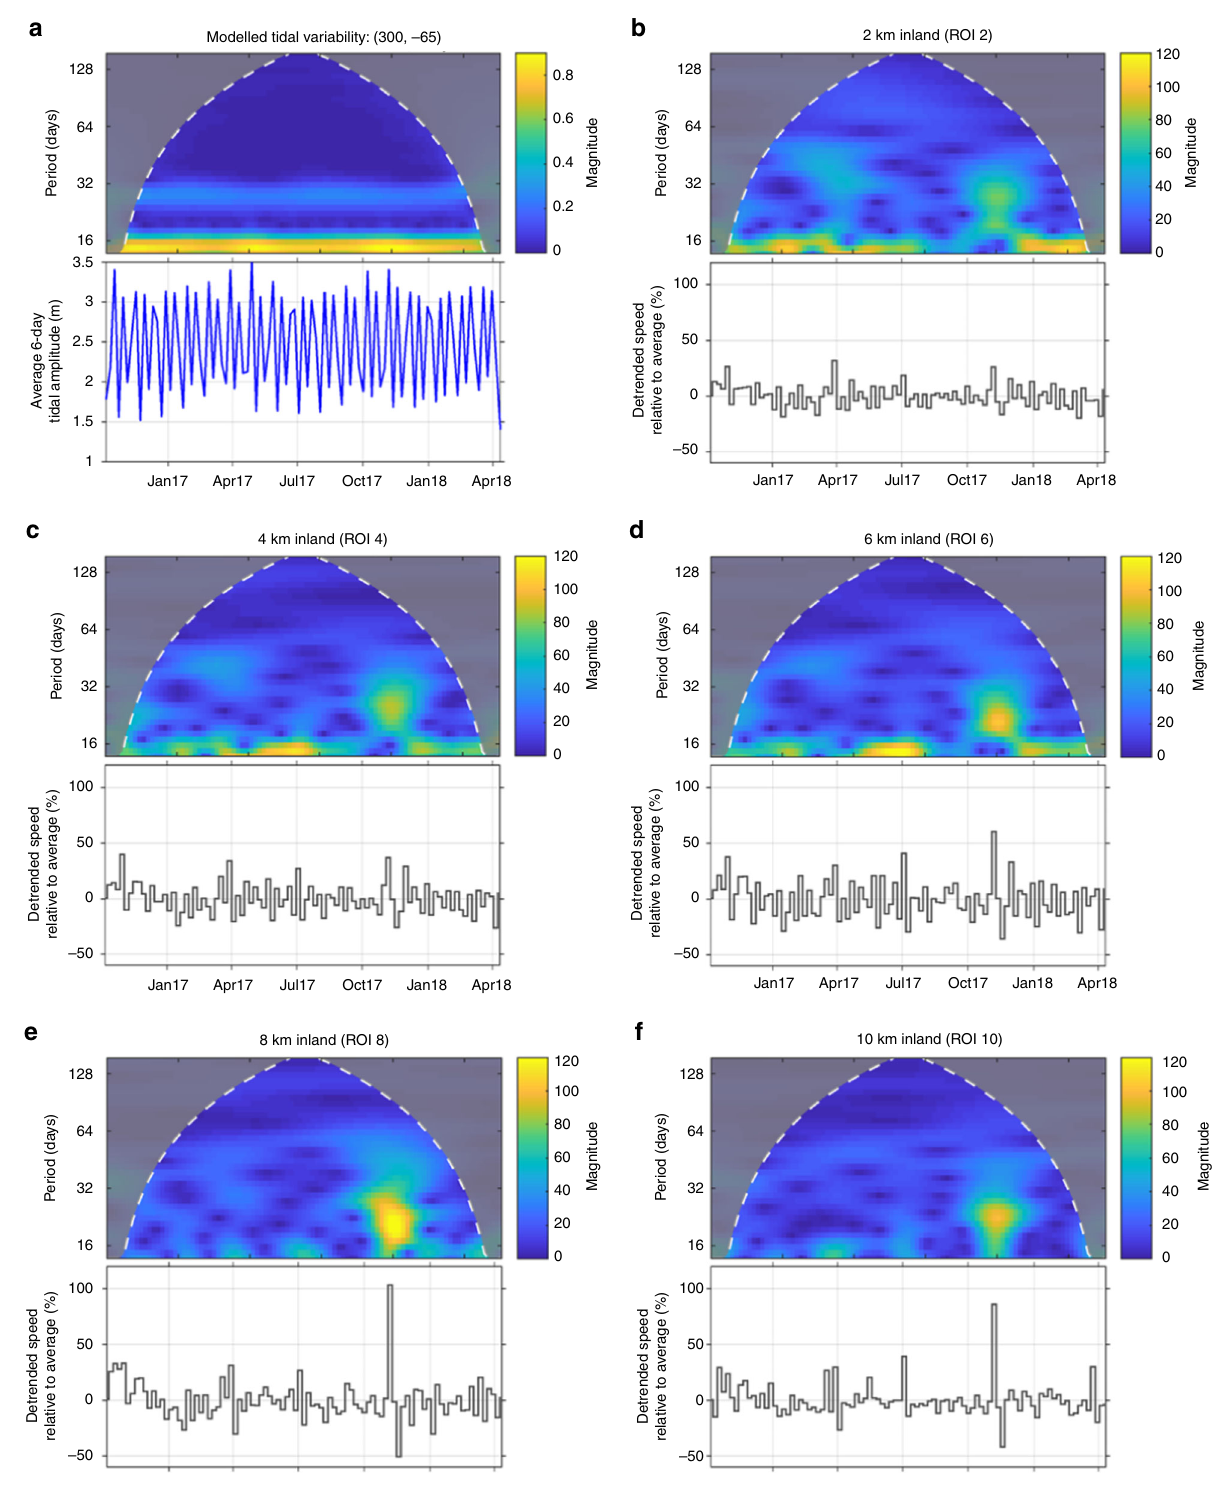
Fig. 4 Periodicity of tides and velocity data. Scalograms (upper) and time series (lower) of tidal a and detrended velocity data b – f of Hektoria Glacier. Scalograms show the strength of signal variability (a strong variability is represented by yellow colours) at each period over time. White line delimits the cone of in fl uence, beyond which edge-effects occur. Note the prominent 14-day periodicity of the tidal model a . This signal is apparent in the velocity data close to the grounding-line b , c , but dissipates further inland e , f , where a more sporadic signal dominates, corresponding to the speed-up events we observe e , f . Note how the relative magnitude of the meltwater-induced speed-up event increases away from the sea up to 8 km before starting to decrease